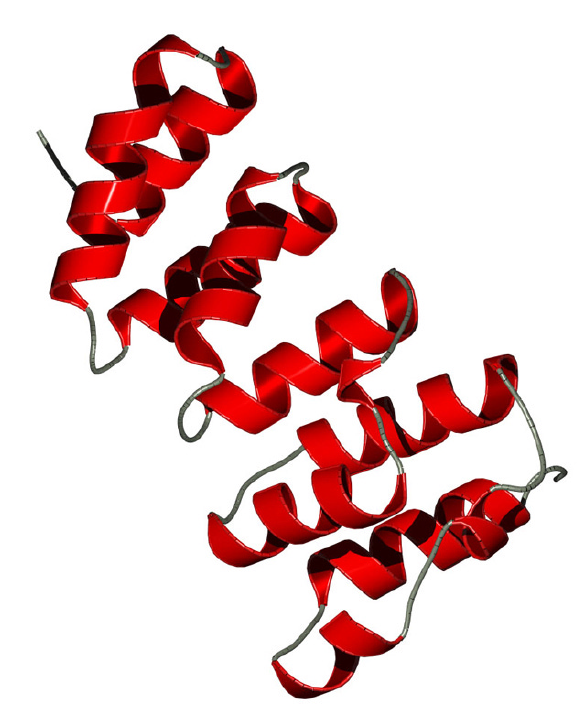
FIGURE 5. Structure of the C-terminal domain of LTA 4 hydrolase. Ribbon diagram of the double layer of nine α -helices (red) comprising the C-terminal